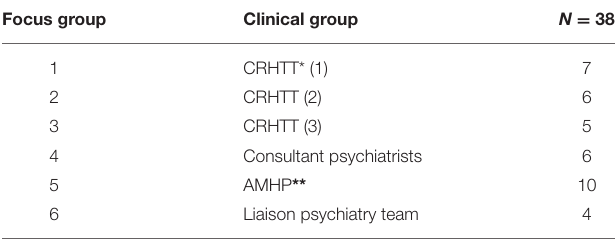
TABLE 1 | Participants who took part in each of the six focus group discussions. Focus group